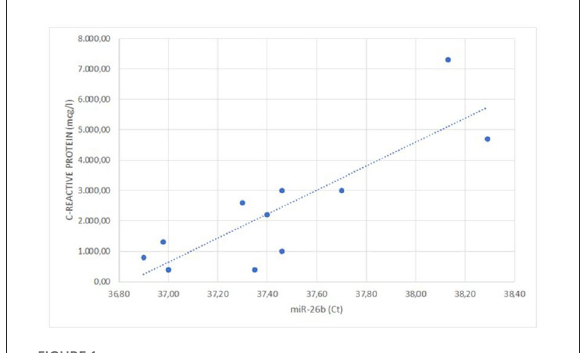
FIGURE1 Linear correlation between the C-reactive protein values and the expression of miR-26b ( r = 0.825; p =